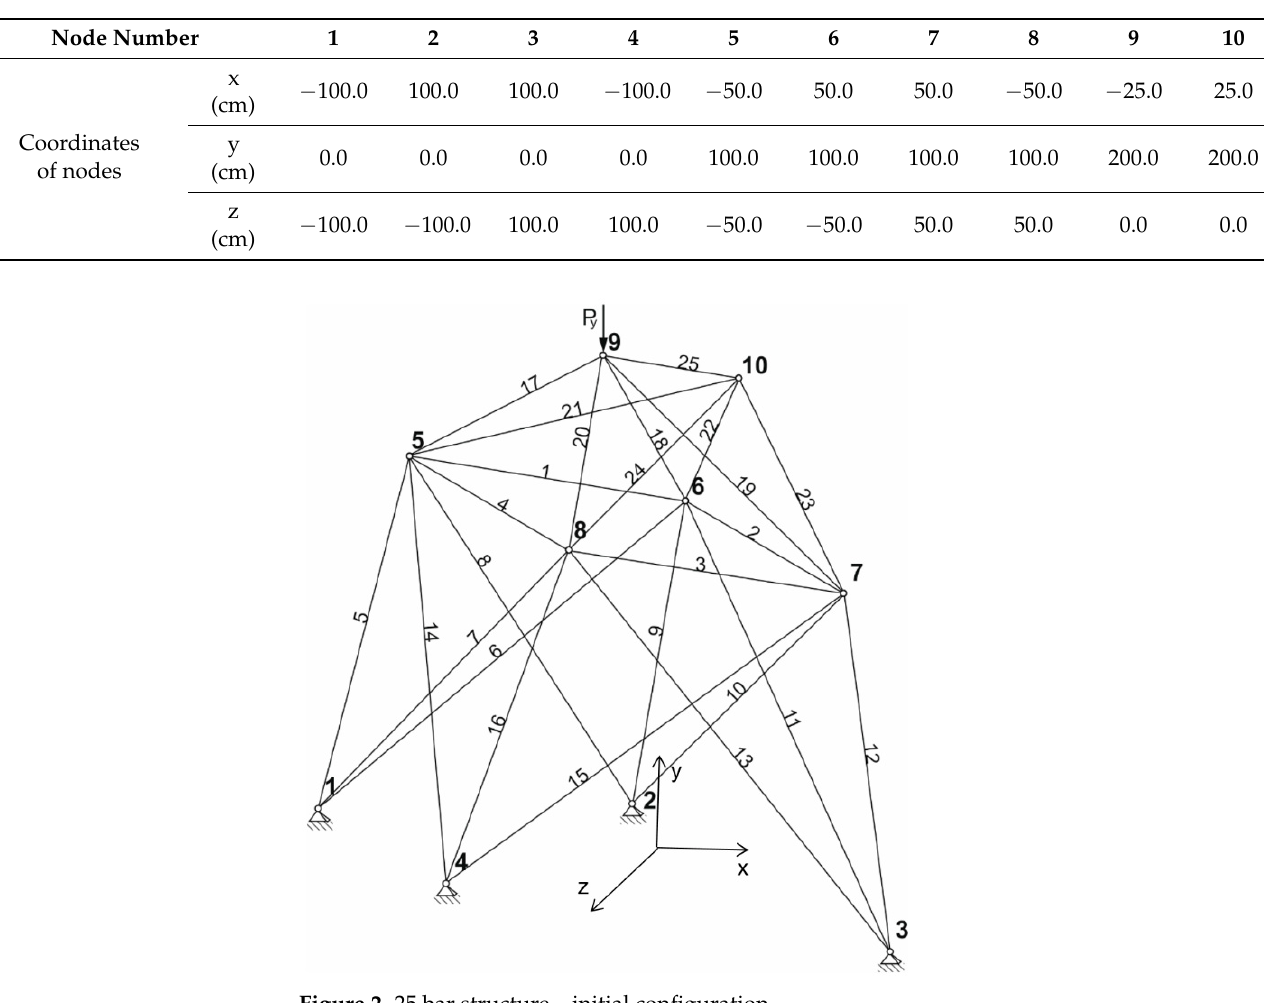
Figure 2. 25 bar structure—initial configuration.